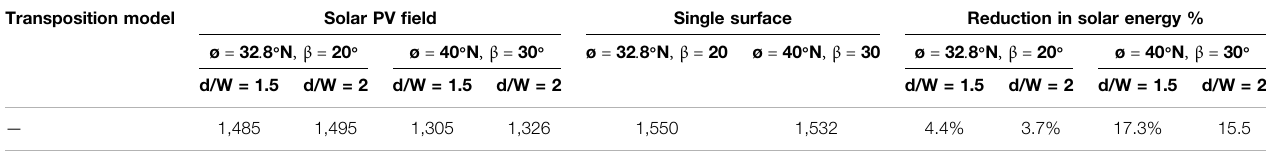
TABLE 4 | Daily solar radiation [W/m 2 /day] incident on the solar PV fi eld and the single surface, under overcast sky conditions. Transposition model Solar PV fi eld Single